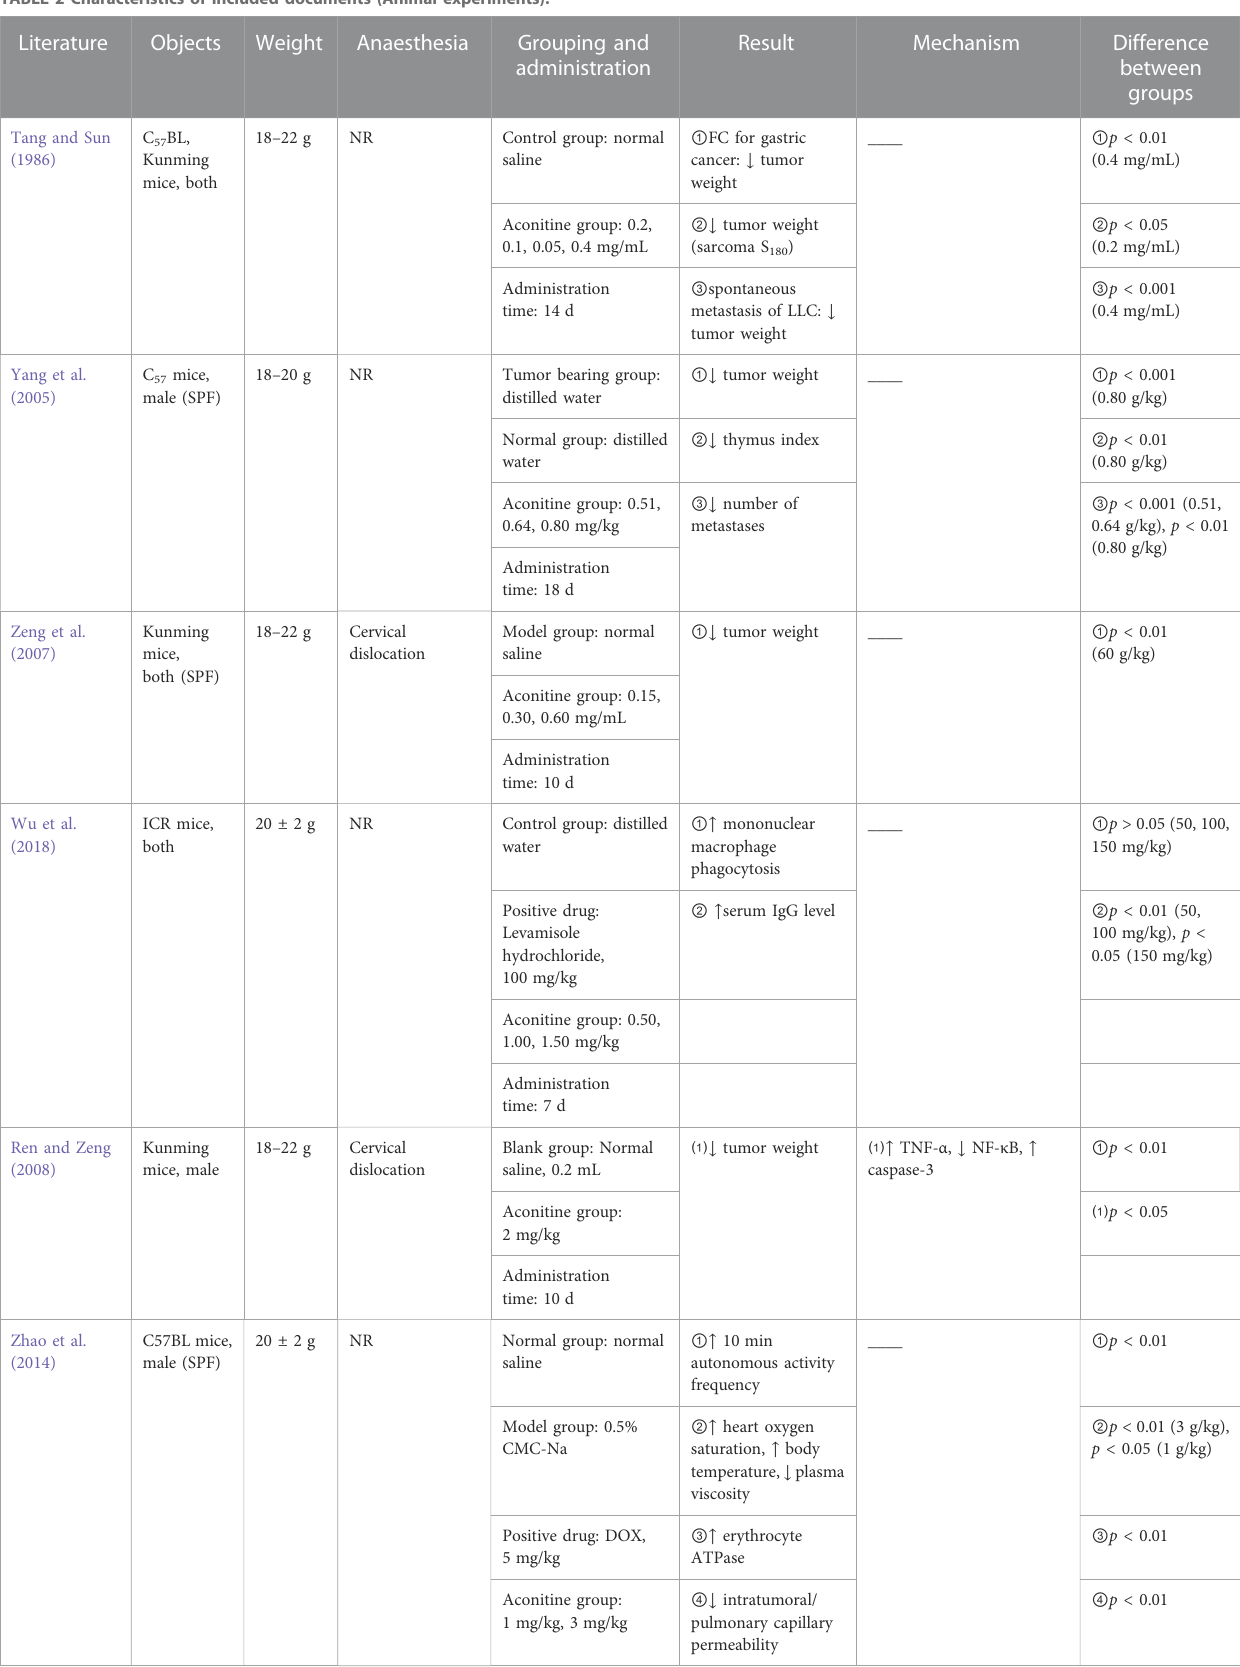
TABLE 2 Characteristics of included documents (Animal